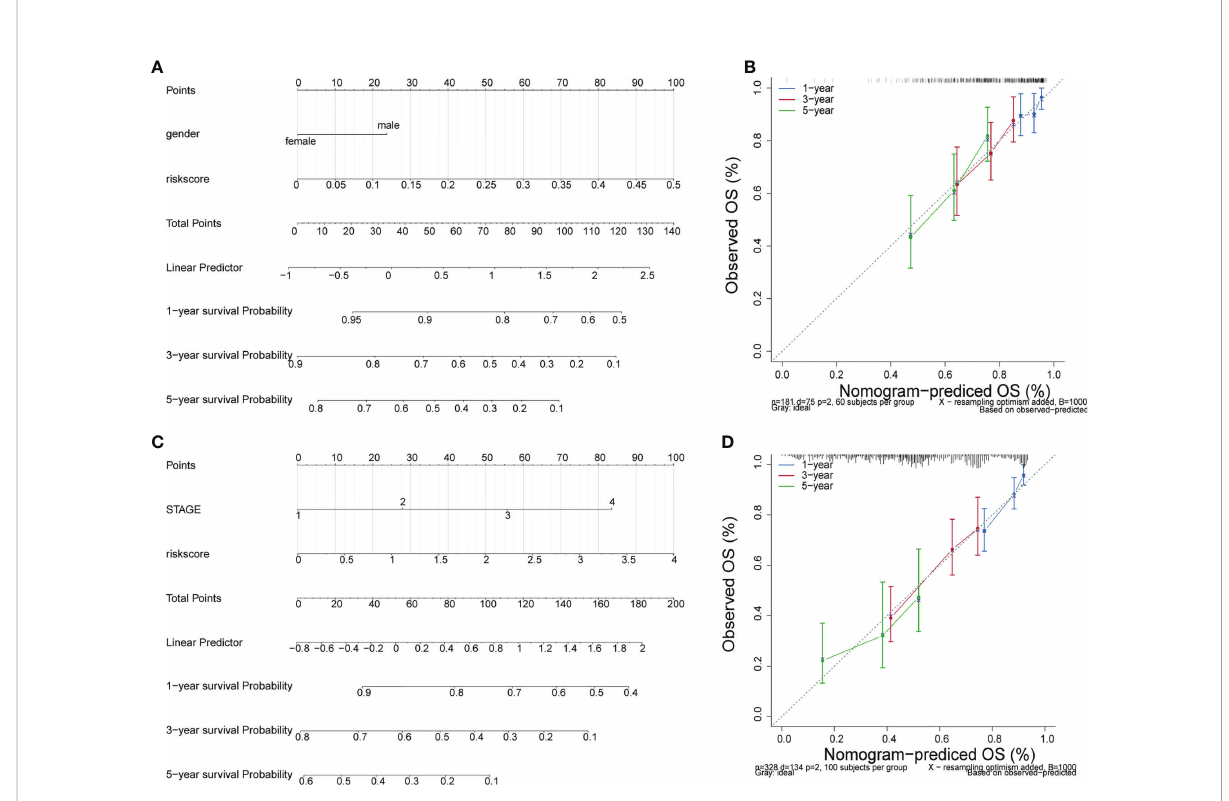
FIGURE 5 Independent prognosis analysis. (A) The nomogram of survival probability based on all independently predictive variables from GEO dataset. (C) The nomogram of survival probability based on all independently predictive variables from TCGA dataset. (B, D) Calibration curves for evaluating the agreement between the predicted and the actual survival rate for the prognosis